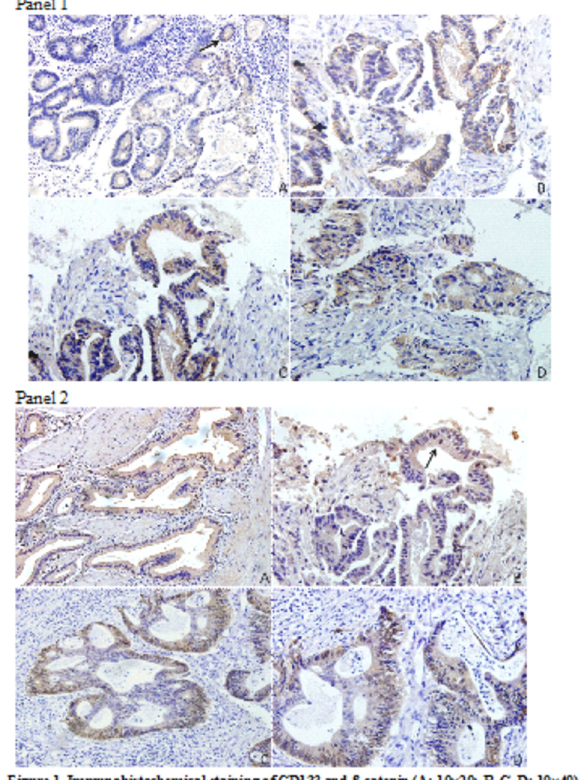
Figure 1. Panel 1: the CD133 antibodies stained intensely at the membrane and in the cytoplasm of cancer cells. (A): weakly positive or focally positive staining in 10% of cells; (B): moderately or strongly positive-staining involving 10% or more of the cells; (C) and (D): the staining of CD133 on the luminal surface and the basal surface of cancer cells. Panel 2: (A): cytoplasmic or nuclear expression of β-catenin was absent; (B): nuclear expression of β-catenin was less than 10% of the cancer cells; (C) and (D): widespread nuclear accumulation of β-catenin.